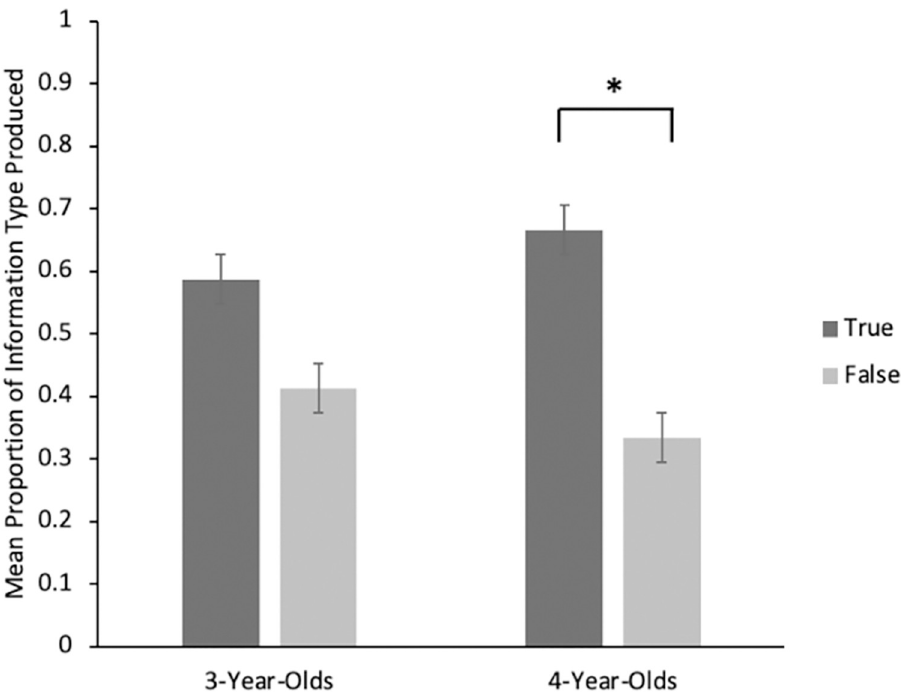
Fig 2. Mean proportion of information type children transmitted in pilot experiment. * p <